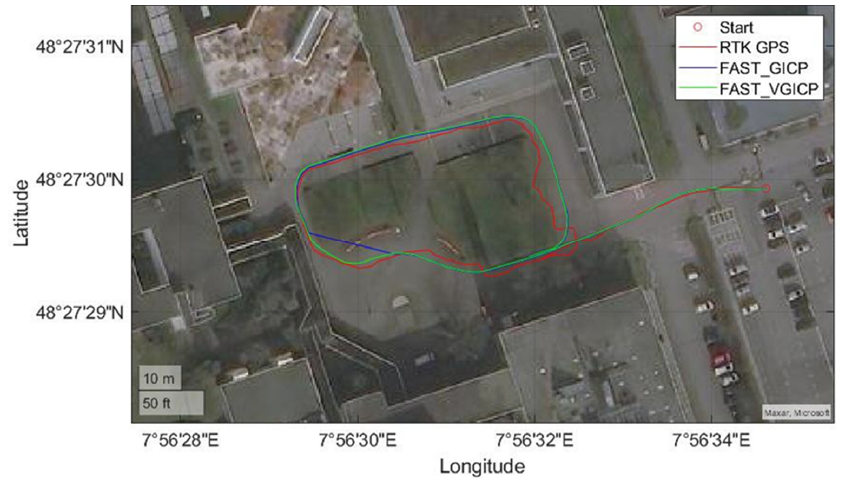
Figure 14. The trajectory on the campus of the Offenburg University of Applied Sciences. Instead, in this test scenario the created map is compared with the map from the Geoportal BW by superimposing it over the map created with hdl_graph_slam (see Figure 15). This shows that the contours of the buildings almost match the map available online. The orientation of the buildings to each other, as well as the dimensions of the generated map, match the reference map.